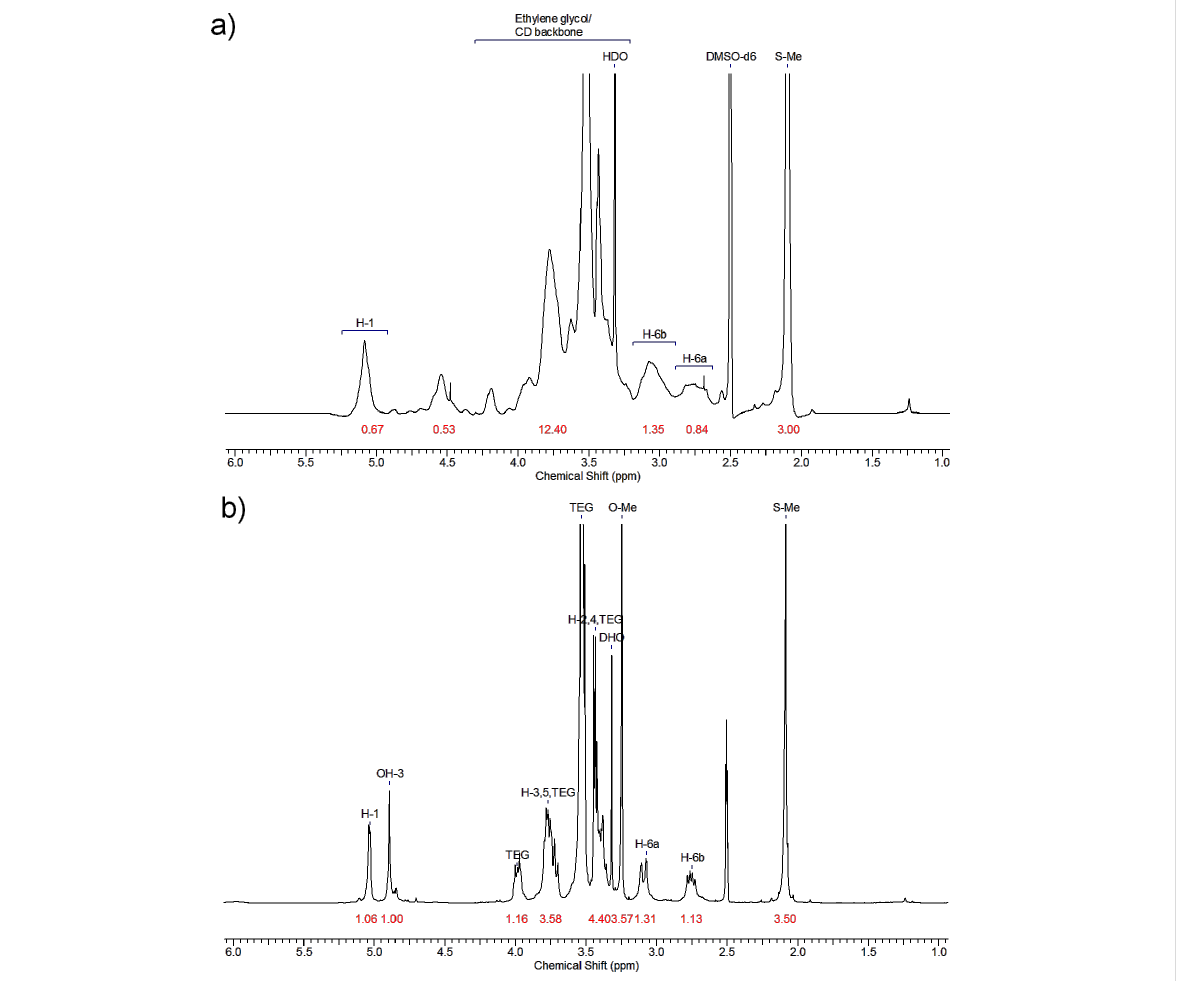
Figure 2: 1 H NMR spectra of a) the statistical CD derivatives 2b 1 and b) the corresponding uniform derivative 3b 1 in DMSO- d 6 (numbers in red are the integrals of the respective signals).